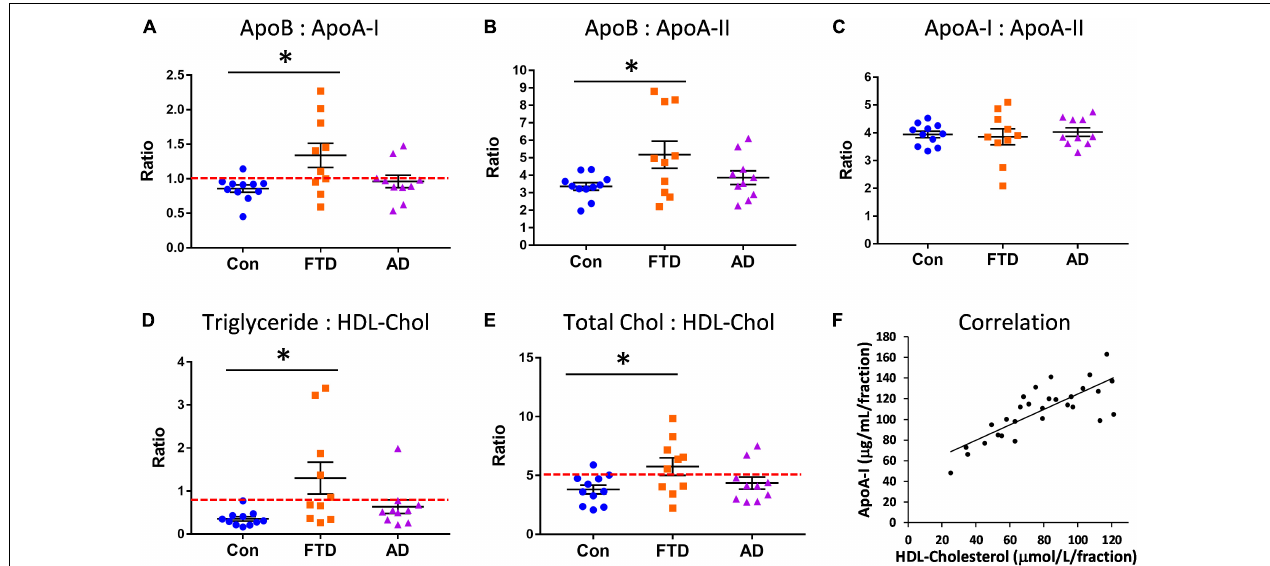
FIGURE 4 | Increased risk for cardiovascular disease (CVD) in bvFTD. (A) The apoB:apoA-I ratio was significantly increased in bvFTD; a ratio value greater than 1.0 (red line) is regarded as increased CVD risk. (B) The apoB:apoA-II ratio was significantly increased in bvFTD. (C) The apoA-I:apoA-II ratio was unchanged in bvFTD and AD. (D) The triglyceride:HDL-cholesterol ratio was significantly increased in bvFTD; a ratio value greater than 0.87 (red line) is regarded as increased CVD risk. (E) The total cholesterol:HDL-cholesterol ratio was significantly increased in bvFTD; a ratio value greater than 5.0 (red line) is regarded as increased CVD risk. Bars represent mean and SE, ∗ p < 0.05. (F) ApoA-I levels correlated positively with HDL-cholesterol